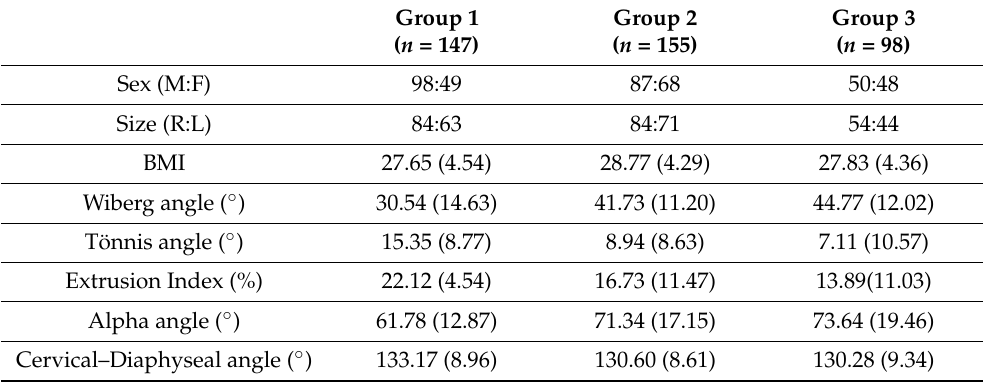
Table 2. Group Demographic Data. Mean (SD). No differences in BMI between groups were assessed ( p >